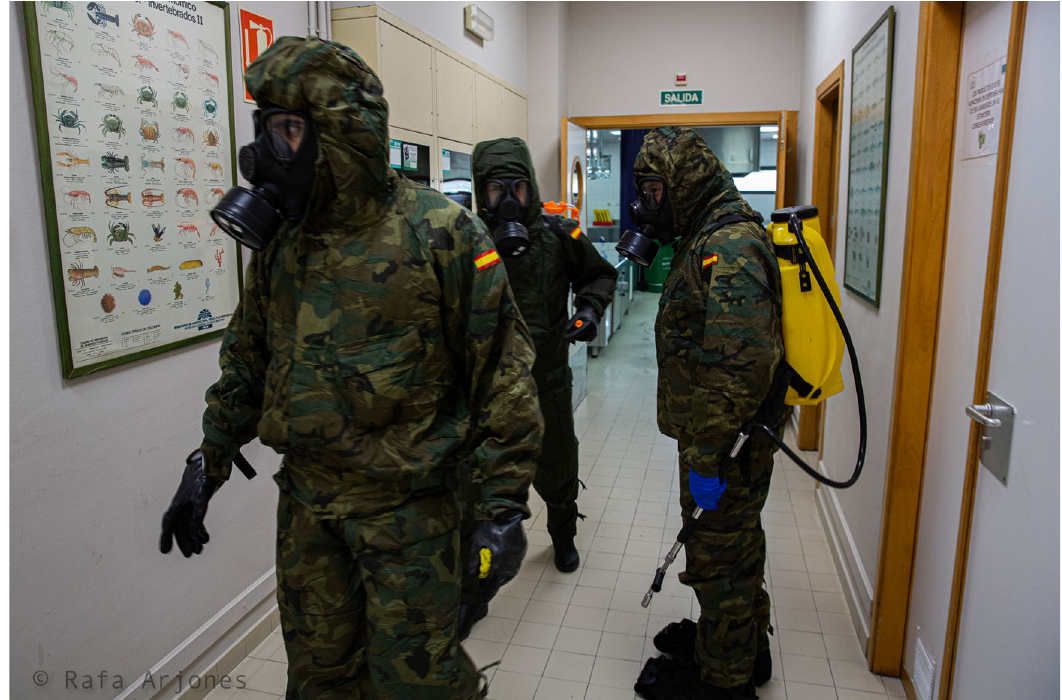
Figure 7. Three soldiers from the Military Emergency Unit wearing protective suits that make it difficult to identify their corporeality. What it can be seen are uniforms that indicate their status and social role. The involvement of the military in the protection processes generated a certain identification of the military with the heroes. This figure has been reproduced with kind permission of the author.